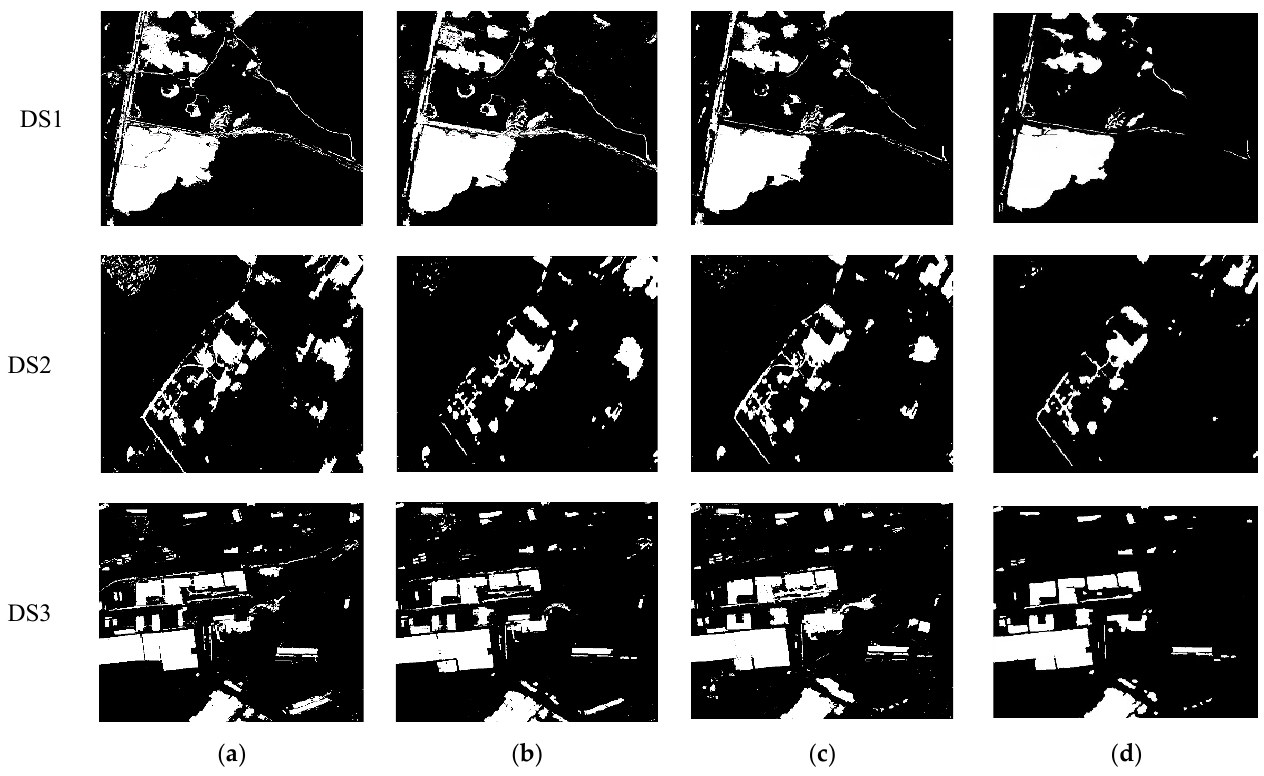
Figure 6. Change detection results in the third experiment: ( a ) spectra; ( b ) spectra + texture; ( c ) spectra + structure; and ( d ) proposed method.